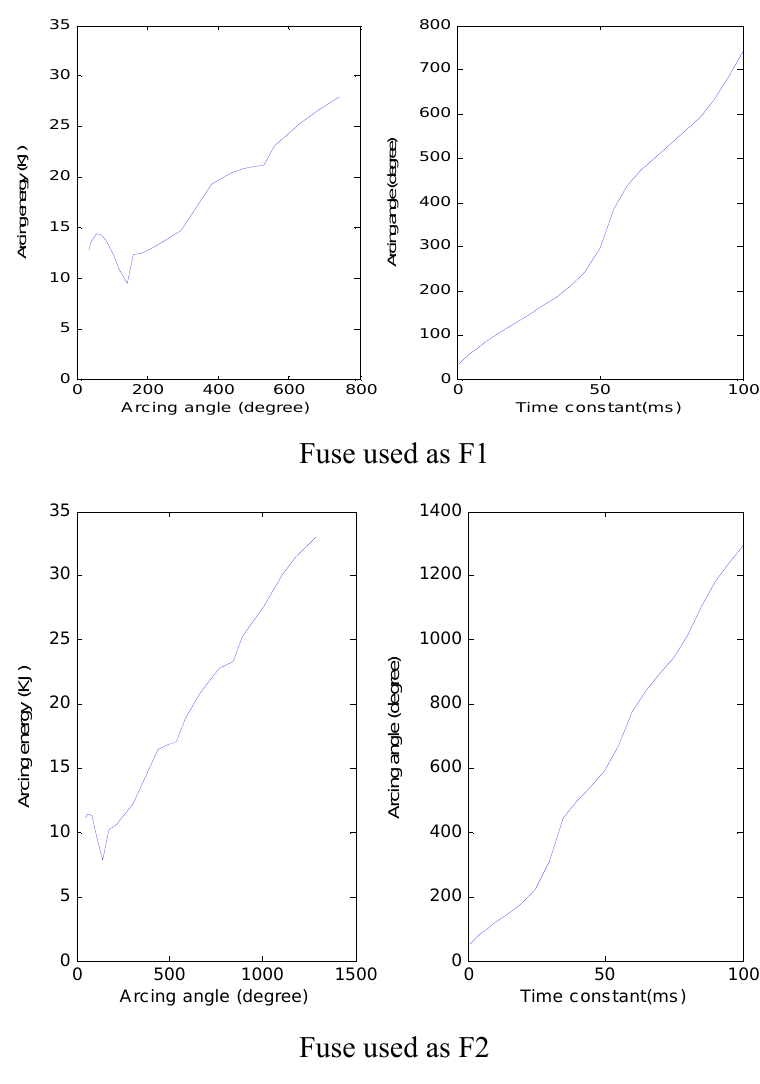
Figure 7. Variation of the arc energy (kJ) versus arc-angle (degree) and arc-angle (degree) versus the DC machine time constant (ms) when the 200 (A) fuse used as F1 and